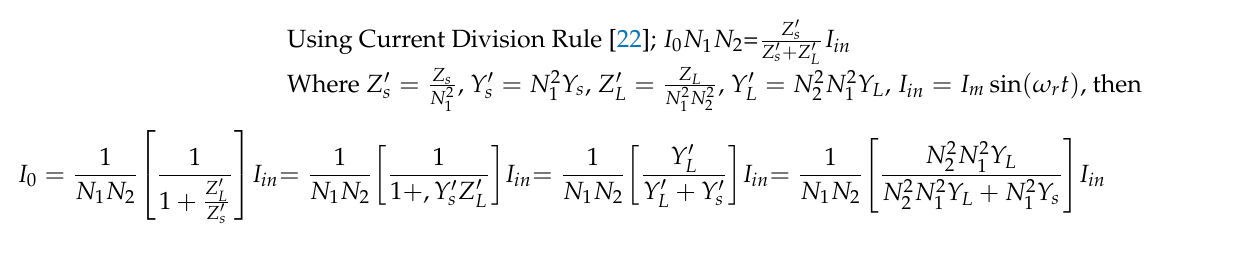
Figure 3. Equivalent multi-stacked DRA simplified circuit.